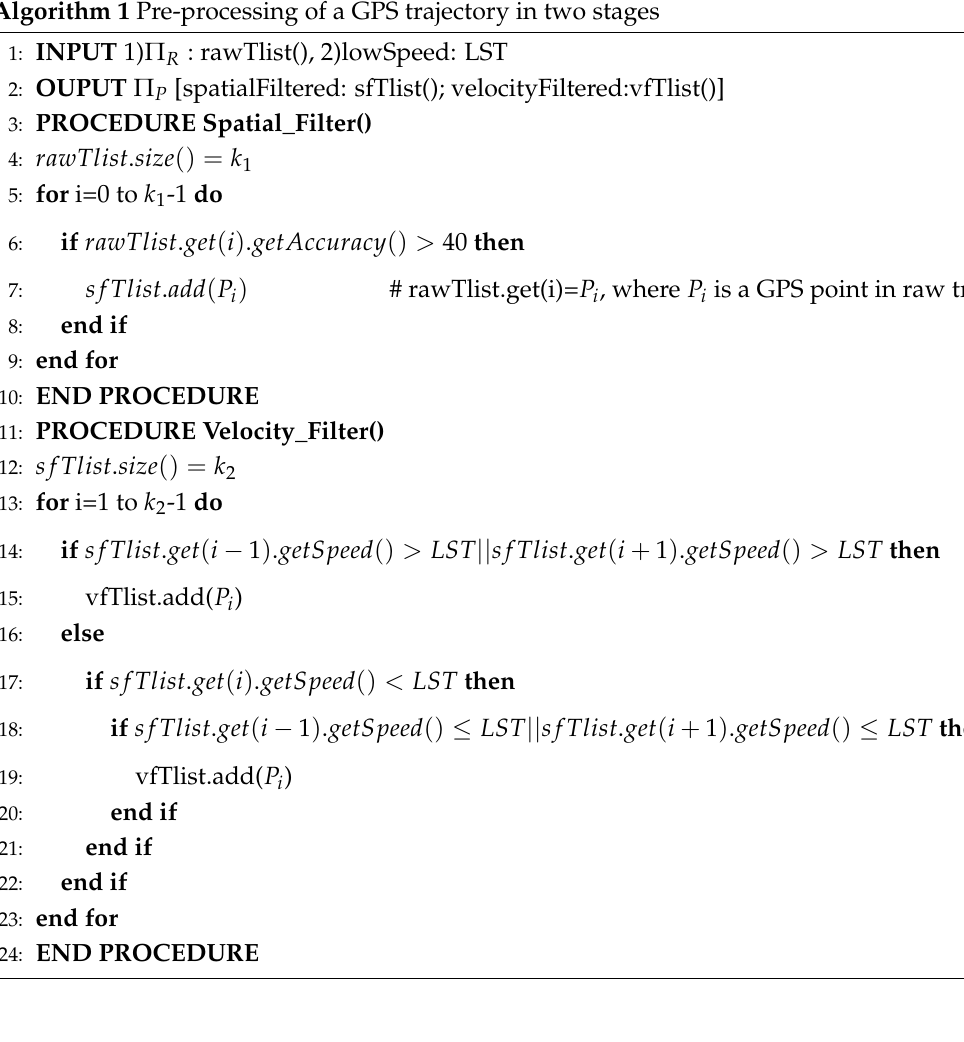
Algorithm 1 Pre-processing of a GPS trajectory in two